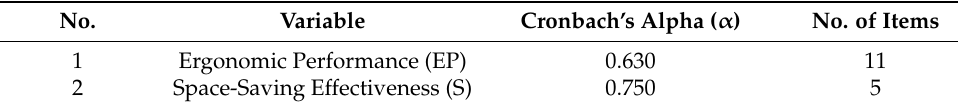
Table 19. Cronbach’s alpha values for survey instrument.